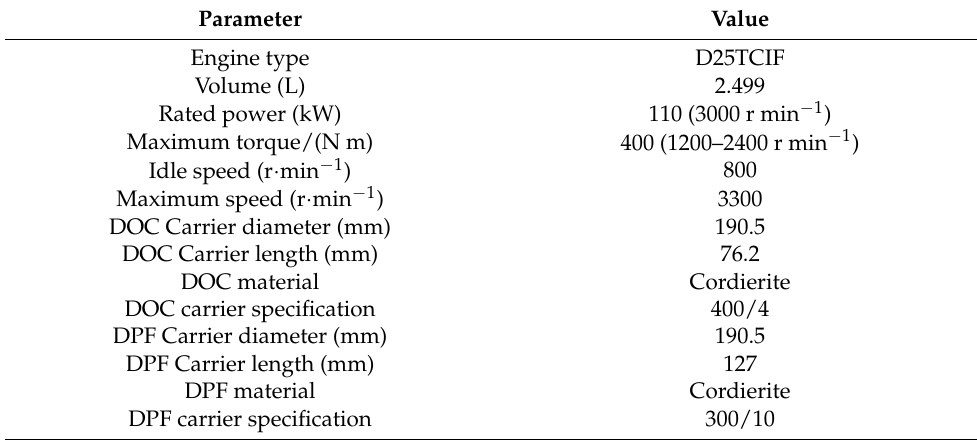
Figure 9. Schematic diagram of the bench test. 1. Exhaust flow direction 2. DOC inlet temperature sensor 3. DOC 4. DPF inlet temperature sensor 5. DPF 6. Delta pressure sensor 7. Thermal couple temperature sensors. Table 6. Component